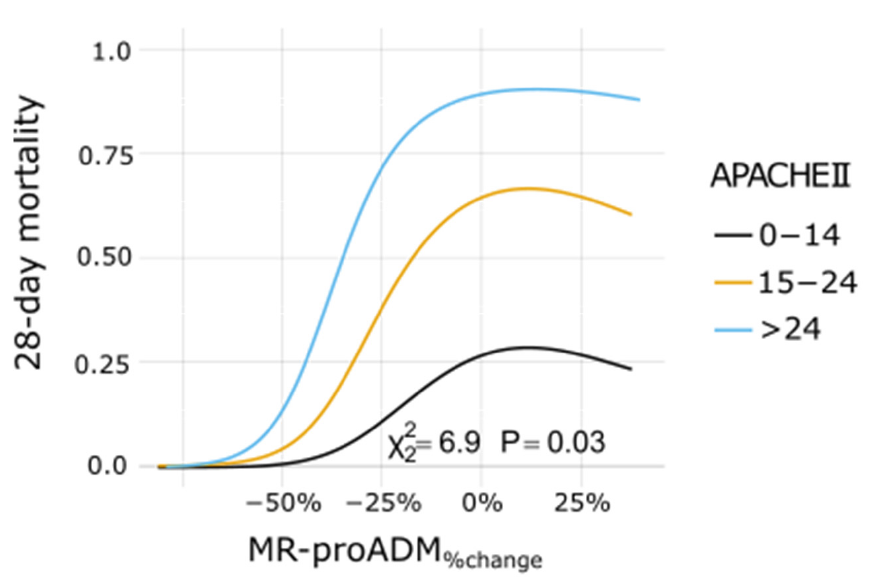
Figure 4. Dose–response plot for 28-day mortality predicted by MR-proADM %change at varying levels of the APACHEII score.